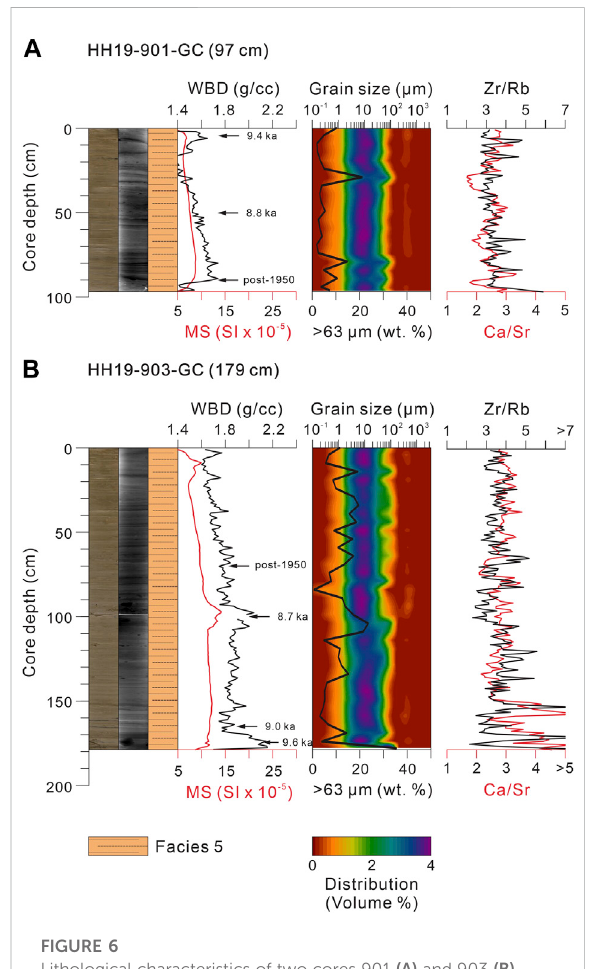
FIGURE 6 Lithological characteristics of two cores 901 (A) and 903 (B) from the fjord basin of Hambergbukta: Split surface and X-radiography images, lithofacies, wet bulk density (WBD), magnetic susceptibility (MS), calibrated 14 C ages, grain size distributions, coarse particle contents ( > 63 μ m), and XRF elemental geochemistry (Zr/Rb and Ca/Sr ratios).